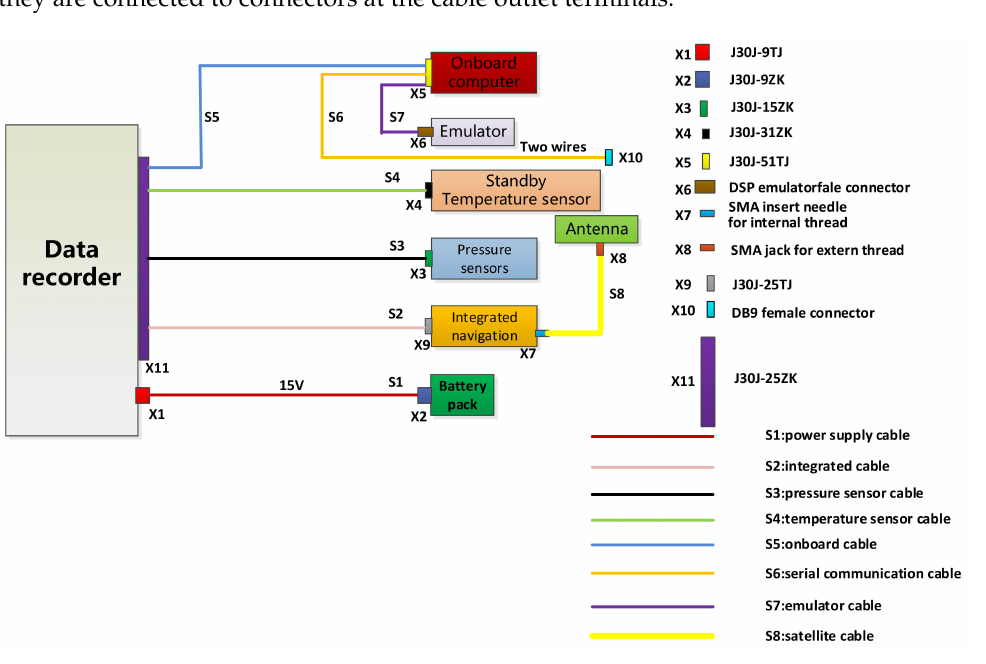
Figure 7. Cable network of the flush air data sensing